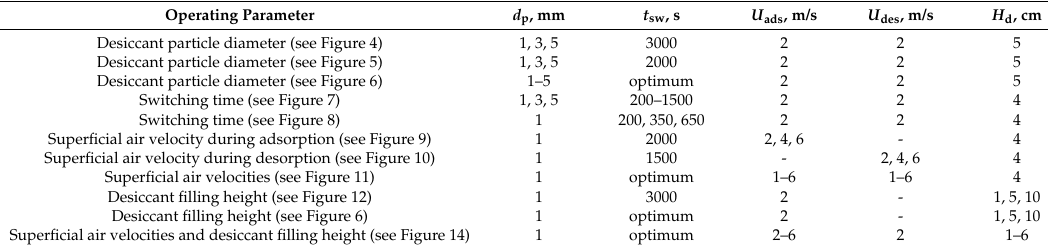
Table 1. Operating parameters used in analyzes.